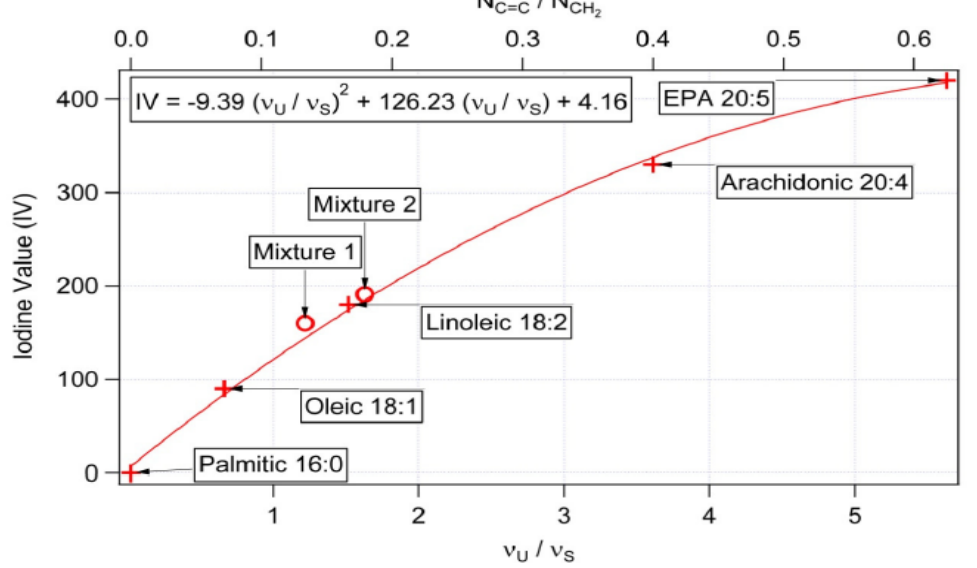
Figure 10. Calibration curve for iodine number determination [31].